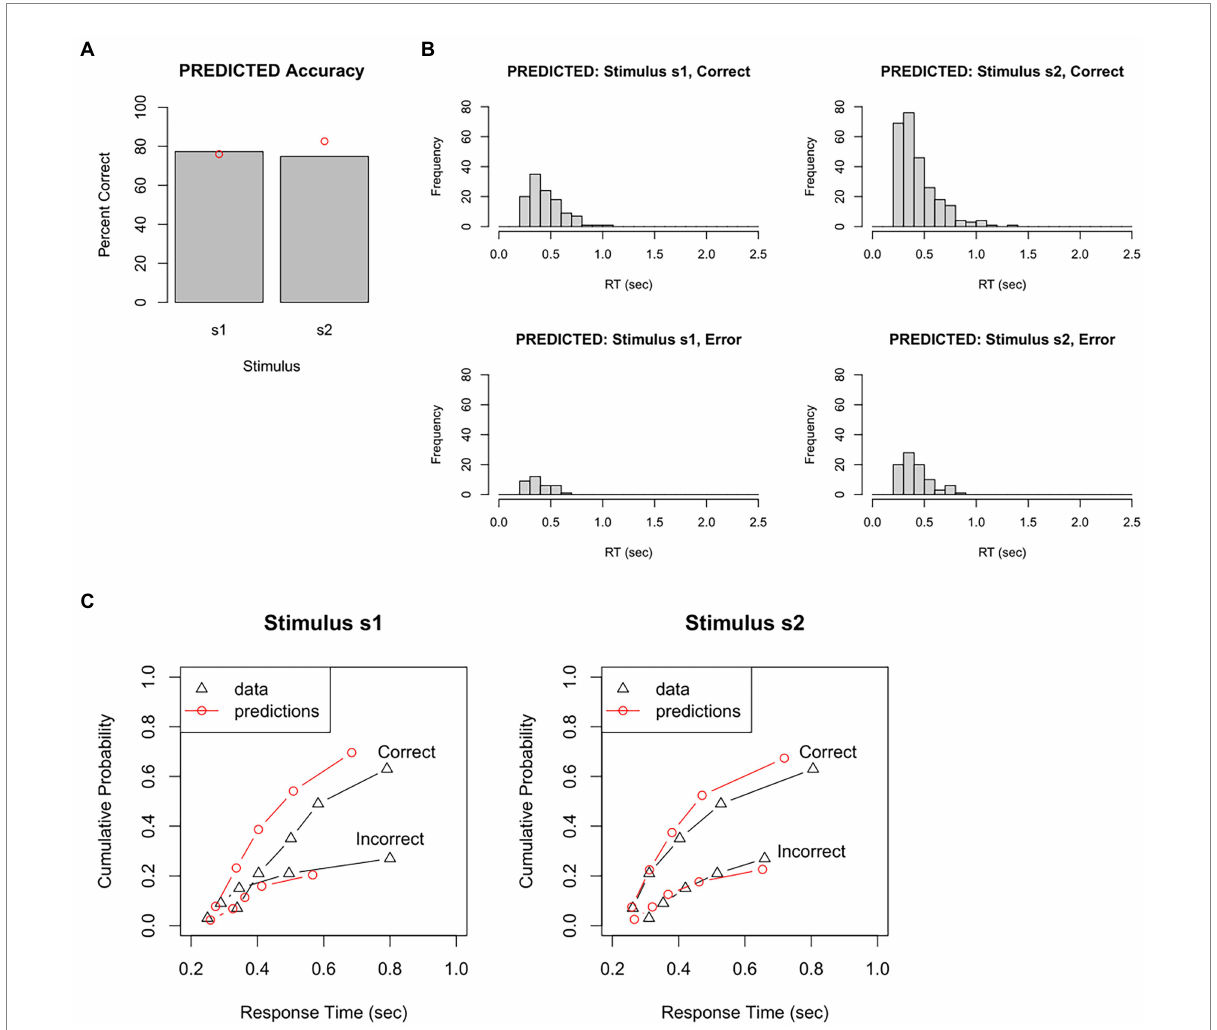
FIGURE 5 Results from a single run of the DDM, given a particular set of parameter values. On each trial, evidence accumulation occurs in the DDM until a boundary is crossed, triggering a response; the response and RT = Td + Ter are recorded for each trial. Just as in the behavioral task completed by our participant, there are 150 s1 trials and 350 s2 trials. (A) The predicted data has accuracy rate similar to, but not identical to, the actual accuracy in the empirical data (red dots). (B) The predicted data also has RT distributions similar to, but not identical to, those in the empirical data (compare Figure 4B). (C) One way of quantifying model fit is by dividing the empirical RT distribution into quantile “bins,” e.g., the RT at which the fastest 10, 30, 50, 70, 90, and 100% of RTs have occurred, plotted here as black triangles (for correct and incorrect responses to each stimulus). The simulated (predicted) data obtained from the DDM are divided into the same bins, plotted here as red circles, and connected by red lines to simulate a CDF. If the predicted data fit the empirical data very well, the red circles would overlie the black triangles. Here, the fit between empirical and predicted data is not great. For example, the model predicts too many correct responses and also too few slow RTs, compared to the empirical data. Predicted data obtained using the RWiener and rtdists package for